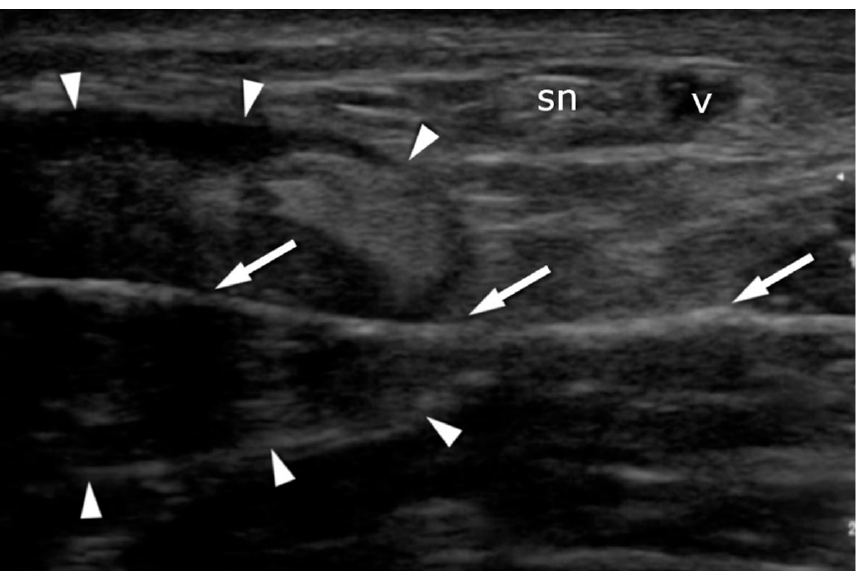
Figure 6. Achilles tendon (arrowheads) suturing: transverse plane. The needle (arrows) is intro ‐ duced under US guidance in order to avoid contact with the sural nerve (sn) and the vein (v).